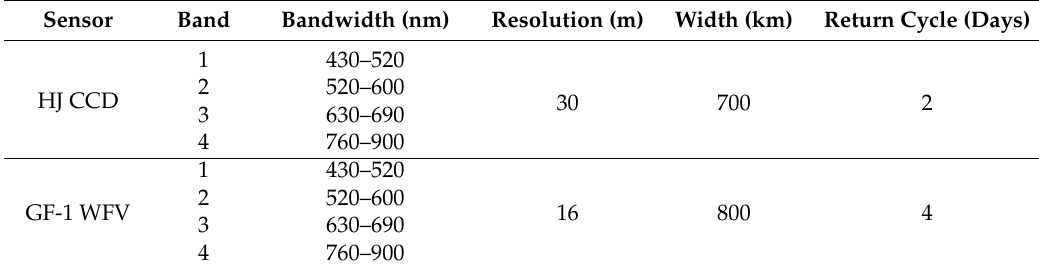
Table 2. Parameters for HJ satellite constellation CCD sensor and GF-1 satellite WFV